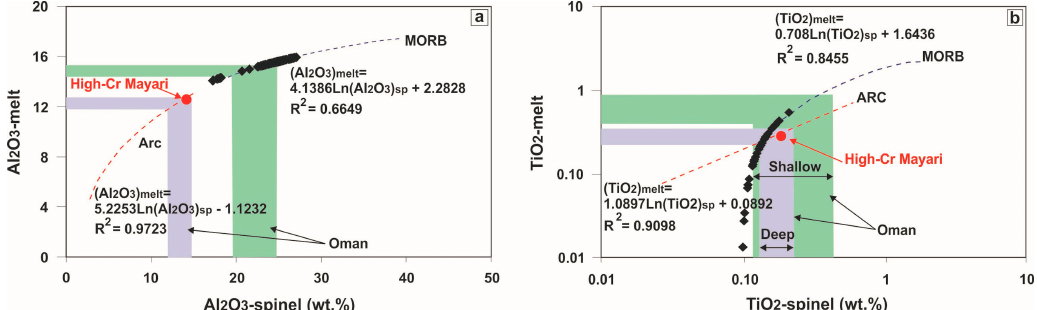
Figure 15. Plots of the calculated Al 2 O 3 and TiO 2 contents of the parental melts in equilibrium with chromitites. The MORB and Arc lines are from [53] using data on spinel-melt inclusions in MORB and arc lavas reported by [45,56]. The range of Cr-spinel and the calculated melt compositions from the chromitites of the shallow and deep mantle section in Oman [56] are shown for comparison. Only data of chromitite samples not associated with gabbroic intrusions were used for computation.